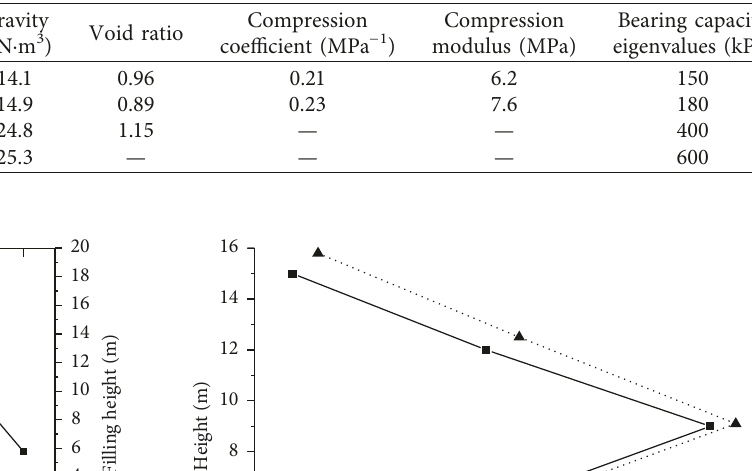
Figure 5: Single-point settlement meters. (a) Layout profile. (b) Planar graph (reproduced from Jia et al. [28] (under the Creative Commons Attribution License/public domain)). Table 1: Physical and mechanical parameters of subsoil (reproduced from Jia et al. [28] (under the Creative Commons Attribution License/ public domain)).